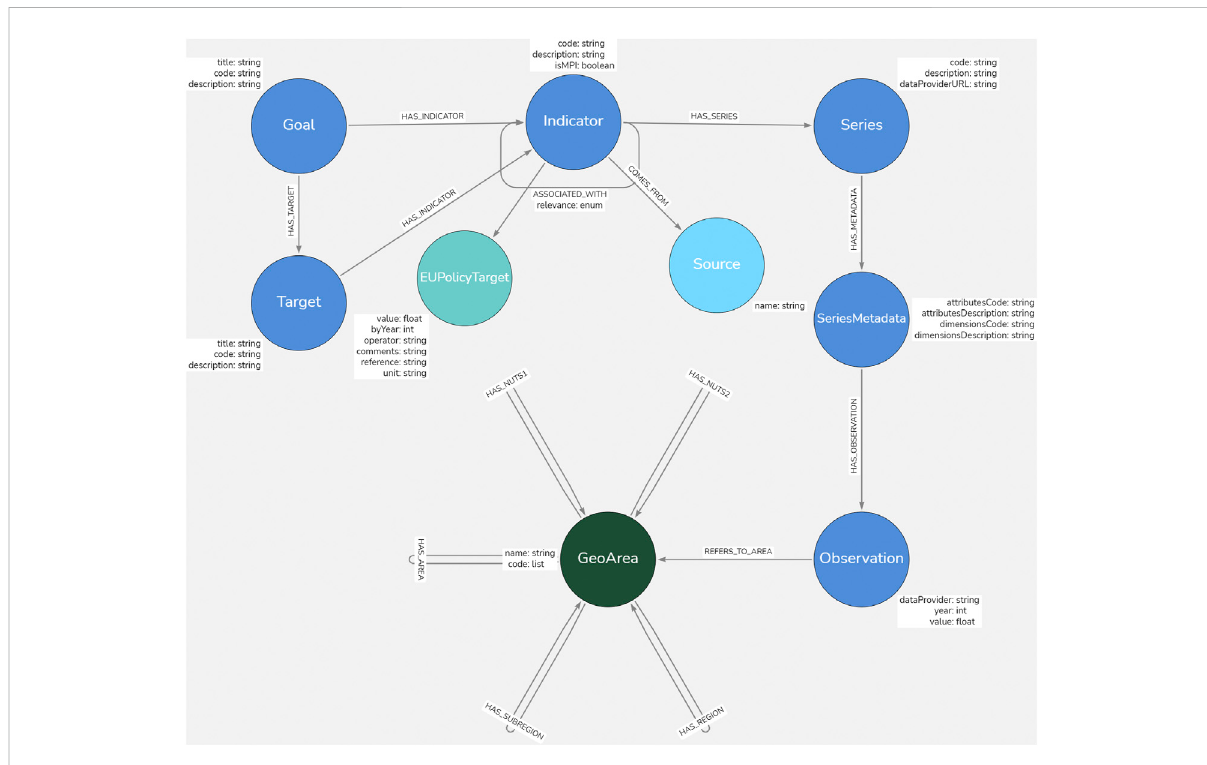
FIGURE 5 Sustainable development goals, targets and indicators in the